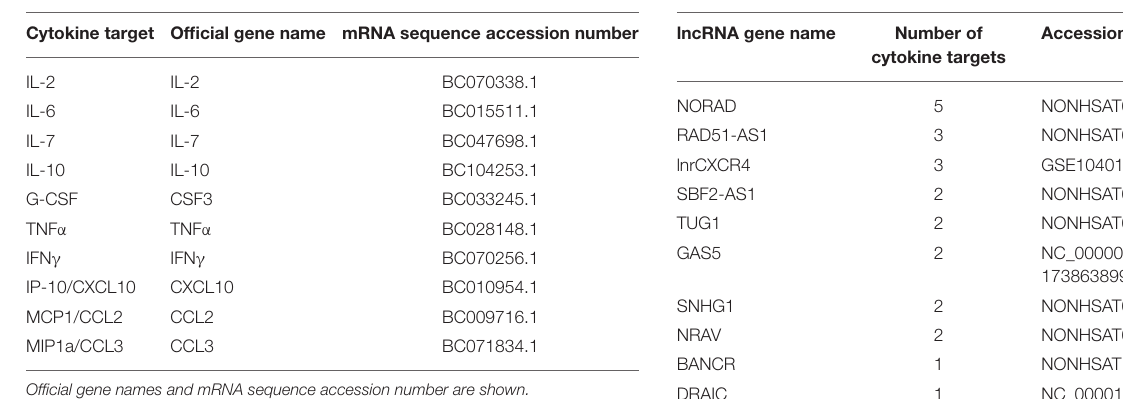
TABLE 1 | COVID-19 cytokine storm significant cytokines used for further lncRNA analysis.